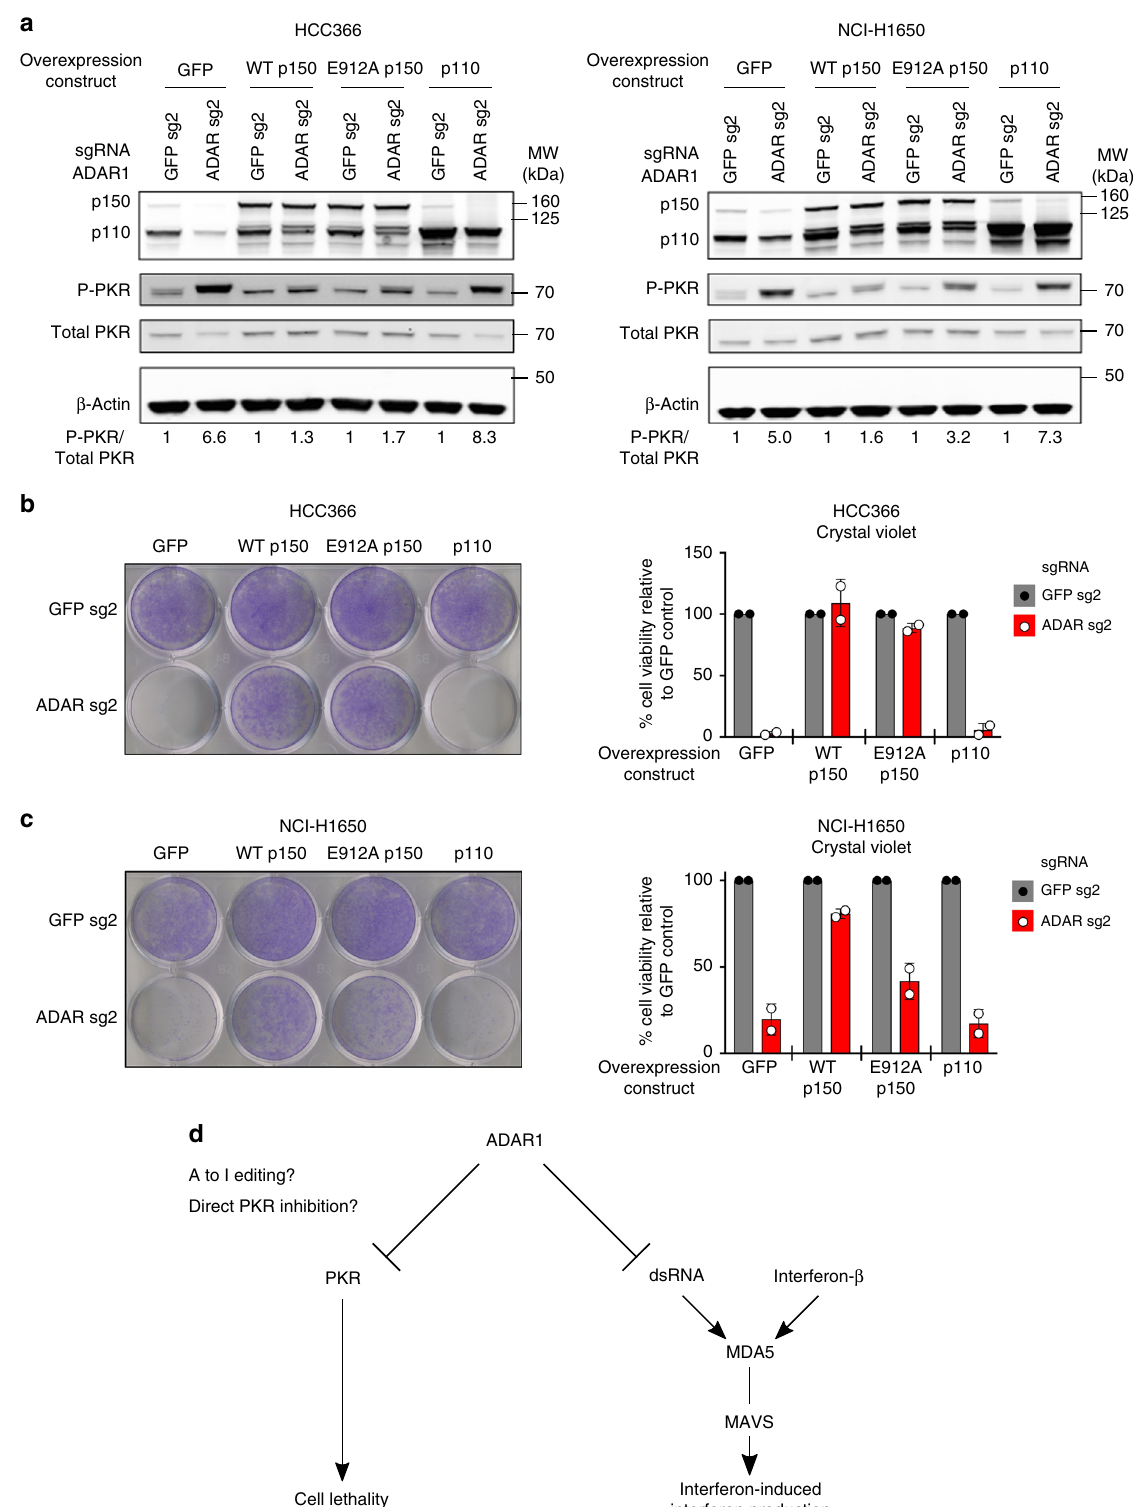
Supplementary Fig.